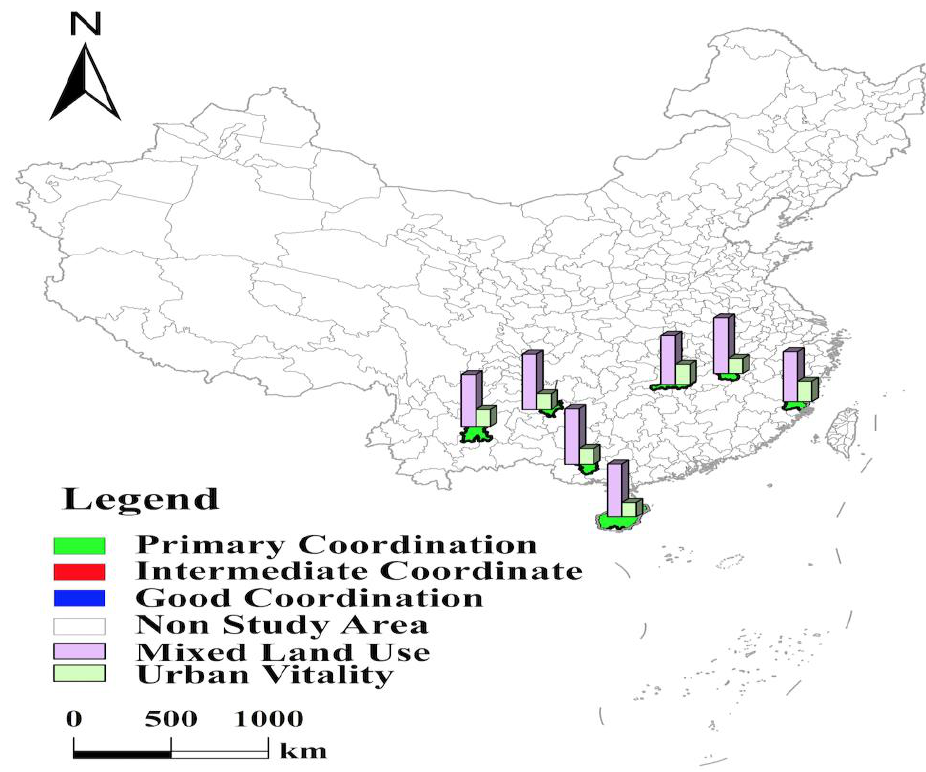
Figure 5. Levels of mixed land use, urban vitality, and coupling coordination in southern part in 35 major cities.